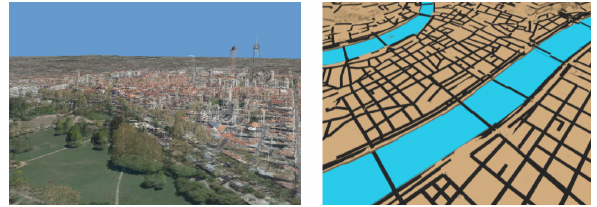
Figure 6. Other available 3D spatial representations : Point clouds (on the left), and from a GeoJSON (the road in black on the right), stored as